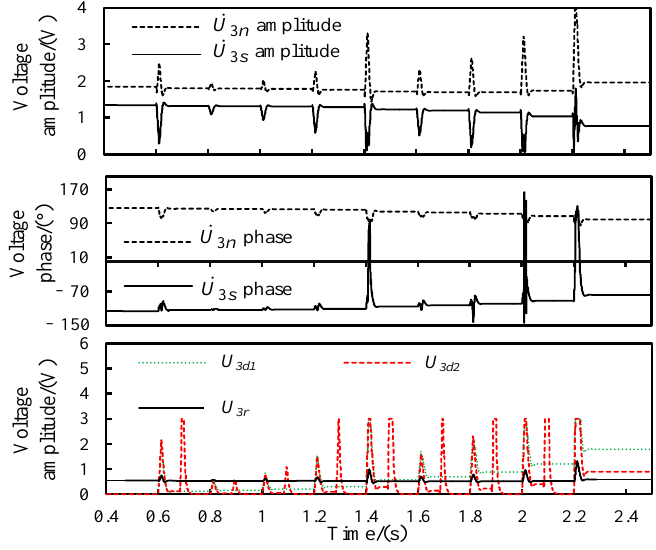
Figure 12. Trip calculation when the generator terminal is grounded via a varied resistor. When the half-wave Fourier calculation sampling window contains a large number of mutated fundamental voltage, the third harmonic voltage cannot be accurately calculated. In order to avoid malfunction, the protection’s action equation should continue to meet 40 ms or more. At the neutral point of the generator, a metal ground fault is simulated at the time of 0.6 s, and the voltages of the generator are shown in Figure 13. 𝑈 𝑛 ̇ is the zero sequence voltage at the generator neutral point, 𝑈 𝑠 ̇ is the zero sequence voltage at the generator terminal point.